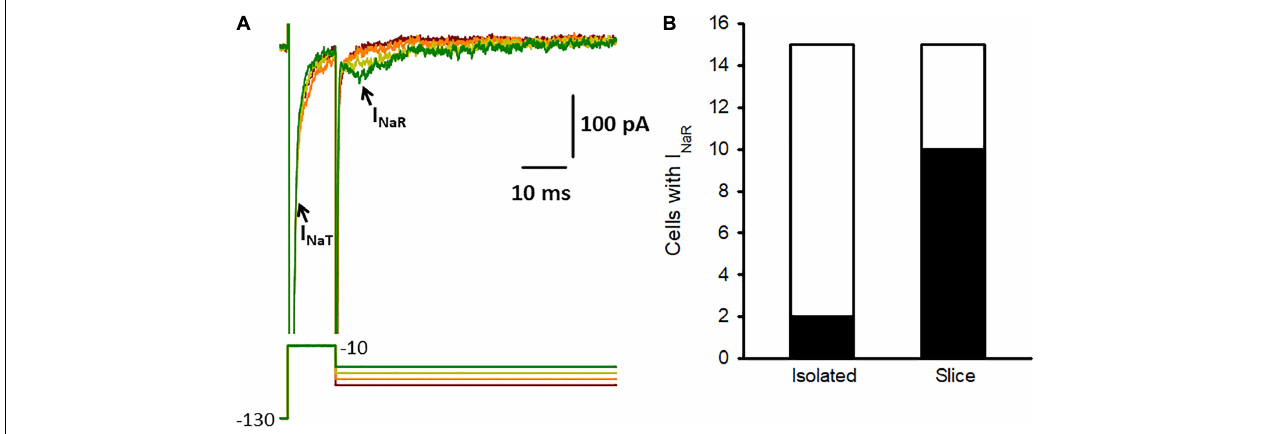
FIGURE 4 | Na + current characteristics in isolated calyces. (A) Na + currents (upper) recorded from an isolated P17 calyx using the voltage protocol shown below. From a holding potential of –90 mV the membrane was stepped to –130 mV for 10 ms and then stepped for 10 ms to –10 mV (complete duration of protocol not shown). The protocol resulted in large transient currents (I NaT , truncated for clarity) at –10 mV, which activated and inactivated rapidly. The membrane was then repolarized to potentials between –75 and –45 mV (10 mV increments shown). Small resurging inward currents (arrow) with characteristics of I NaR were seen following repolarizing steps to –35 mV and –45 mV and strongly resembled I NaR previously recorded from calyces in slices (Meredith and Rennie, 2020). (B) I NaR was seen in most calyces in crista slices (10 of 15 cells tested at age P13-15), but was rarely observed in isolated calyces (2 of 15 cells tested, age range P15-33). Electrode solution for these recordings contained Cs + and the HEPES-based external solution contained 120 mM Na +